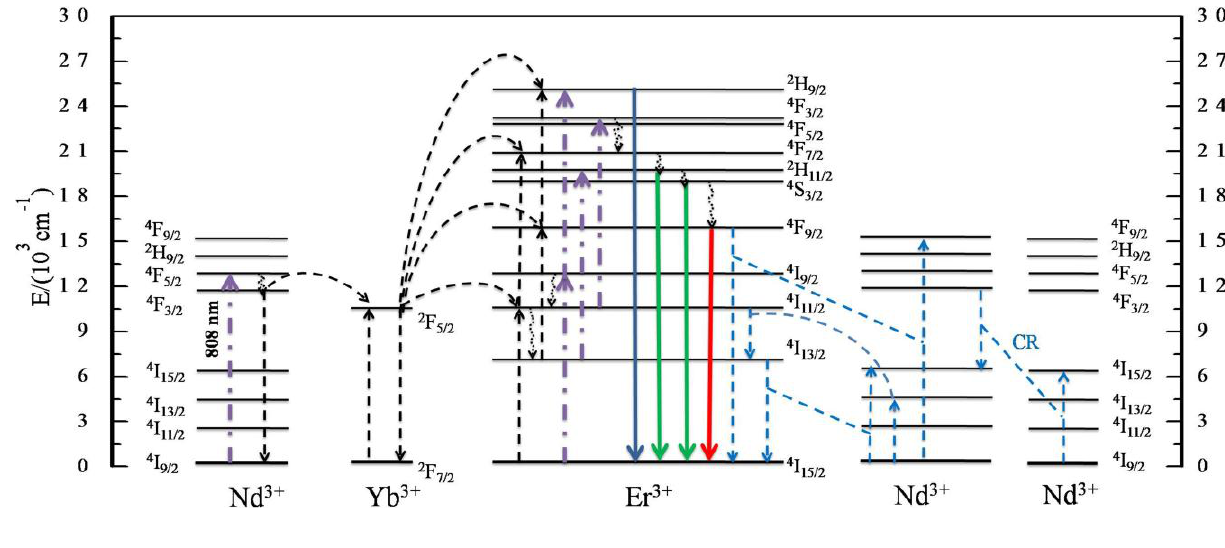
Figure 9. Proposed energy transfer mechanism under 808-nm excitation in NaYF 4 : Yb/Er/Nd nanoparticles. The dashed-dotted, dashed, dotted and full arrows represent photon excitation, energy transfer, multi-phonon relaxation and the emission process, respectively. For clarity, only dominant energy transfer processes are shown in the proposed